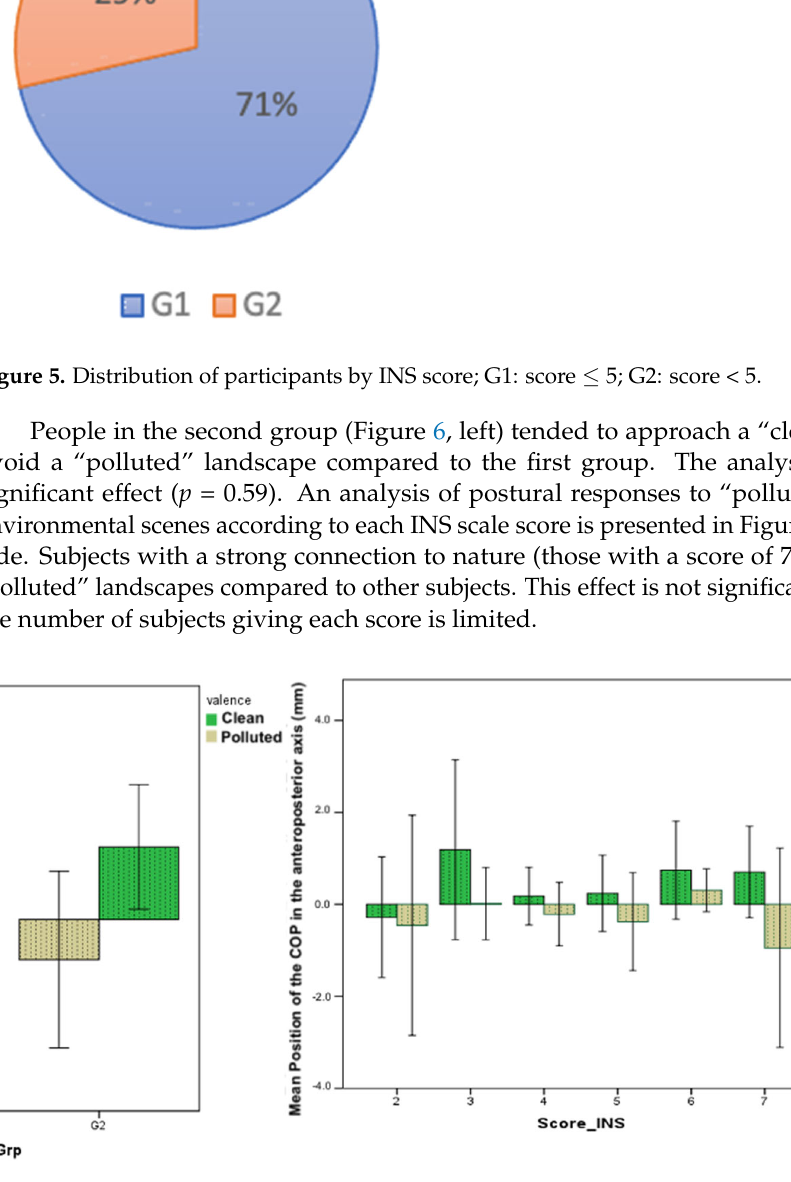
Figure 6. ( left ) Displacement of the COP in the AP axis according to the connection to nature. ( right ) Shift of the COP in the AP axis according to the INS score (Inclusion of Nature in the Self index). For the EMCE scale, participants are grouped into three groups based on their re ‐ sponse (Figure 7, left side). The first group, G1, contained 7% of all cases ( n = 2) with low scores on all types of motivation except amotivation. The second group represented 28% of participants ( n = 8) with moderate scores on all five MTES subscales. Finally, group three, G3, was the largest, comprising 65% of subjects ( n = 20). This group scored high on all types of motivation except amotivation (Figure 7, right side).